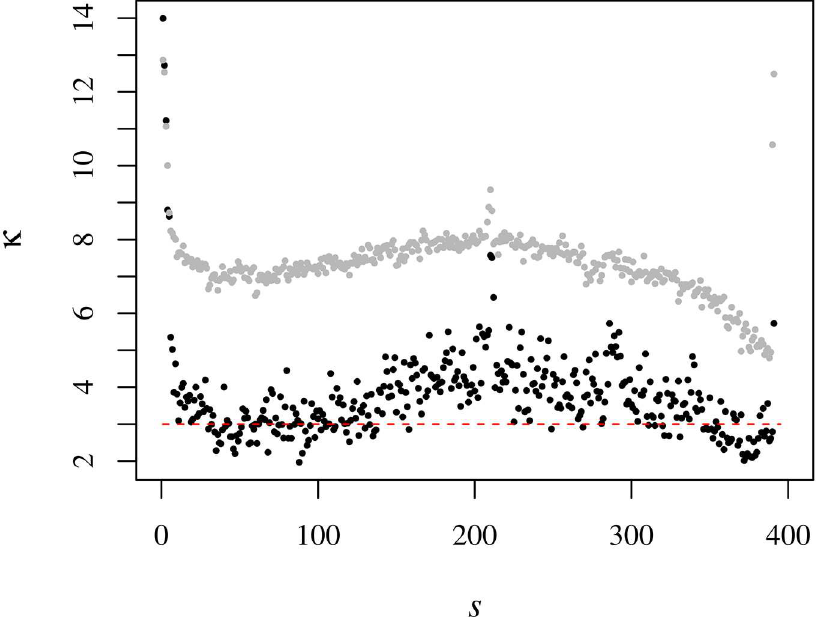
Fig 16. Intraday kurtosis v time t . The black dots represent ^ k ð t ; s Þ averaged over the semesters (excluding those in the interval between s = 11 and s = 16). For mere comparison purposes, we present ~ k ð t ; s Þ using the grey symbols as well. The dashed red line represents the value of the kurtosis for Gaussian distributed